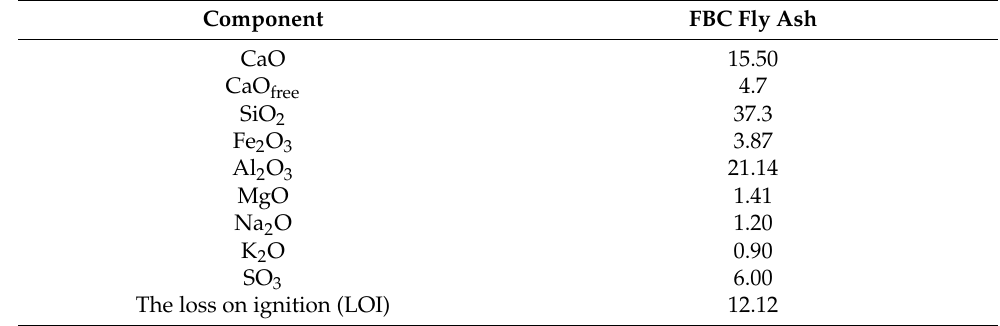
Table 2. The chemical (oxide) composition of the examined FBC fly ash, %.